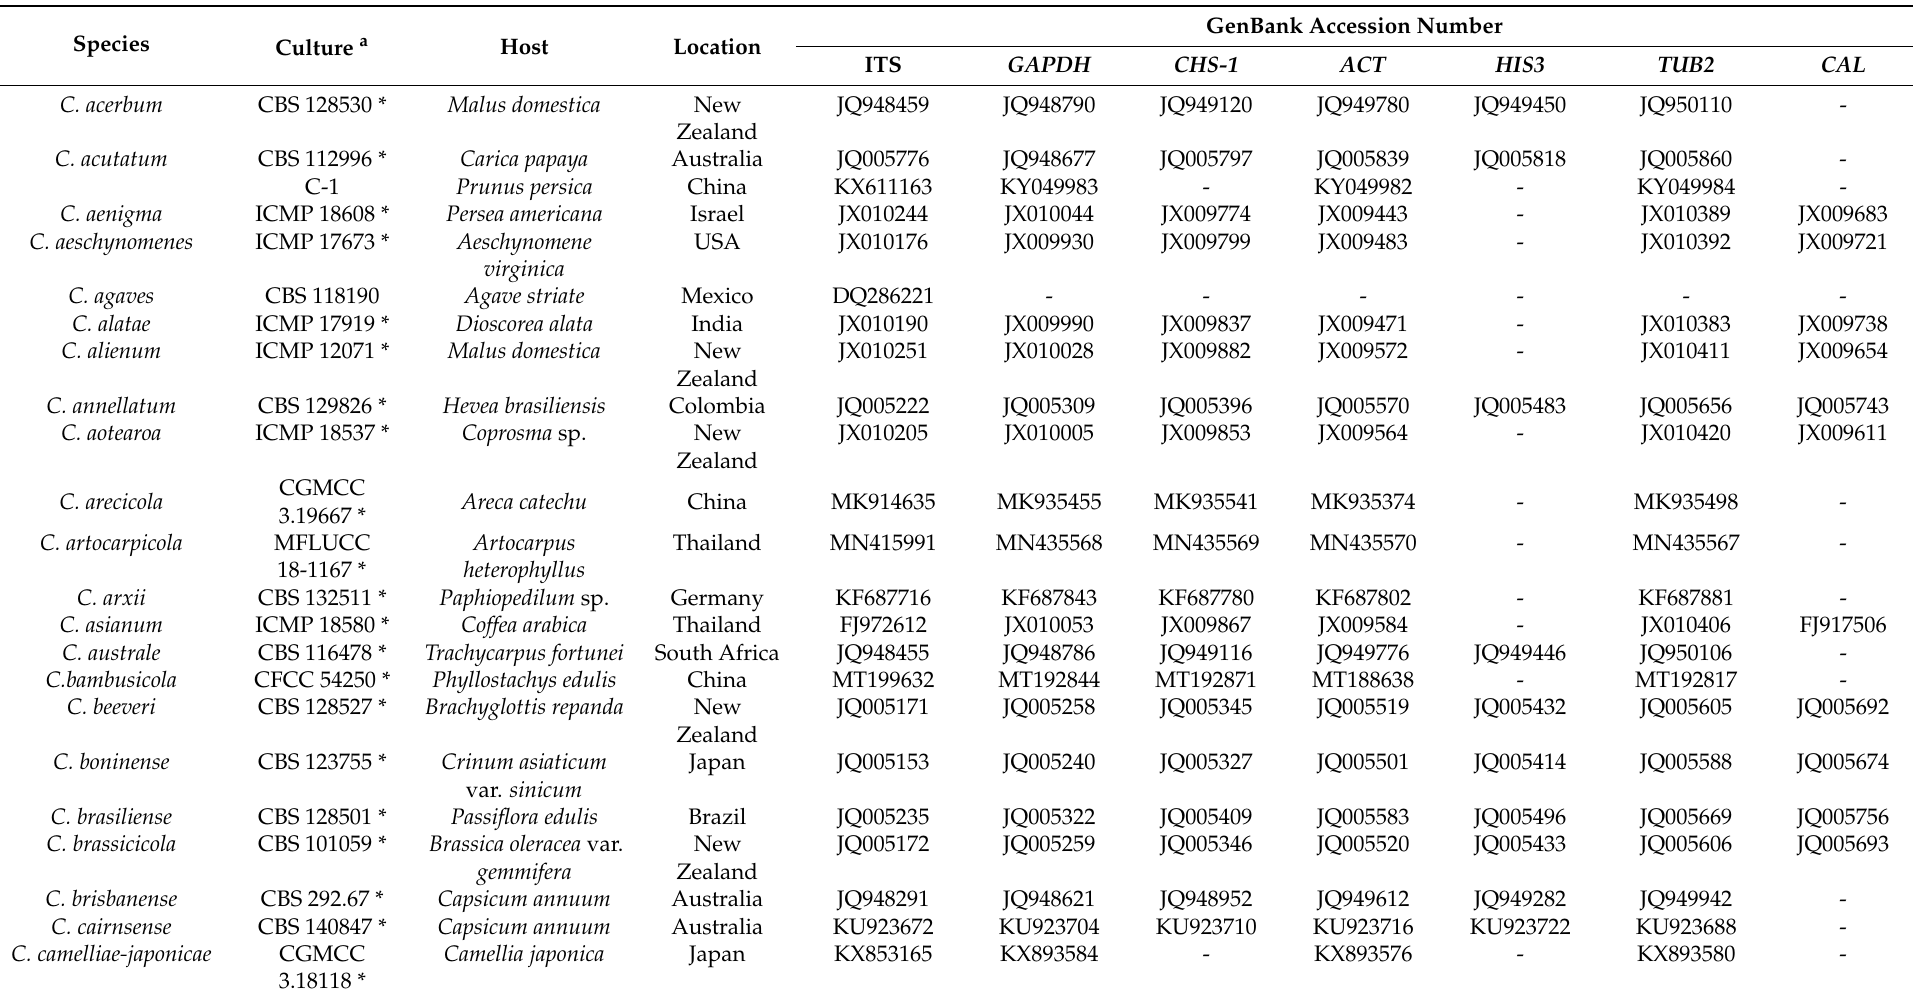
Table 1. Strains used for the phylogenetic analysis of Colletotrichum spp. and other species with details about host, location, and GenBank accession numbers. Species Culture a Host